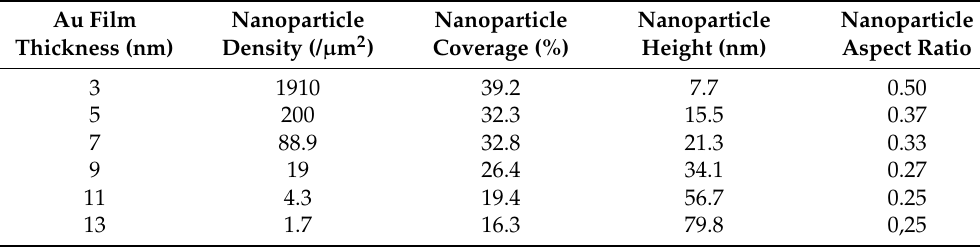
Table 1. Statistics of nanoparticle structures patterned from rapid thermal process (RTP) of thin Au film in terms of Au film thickness, structure density, coverage, thickness, and aspect ratio.